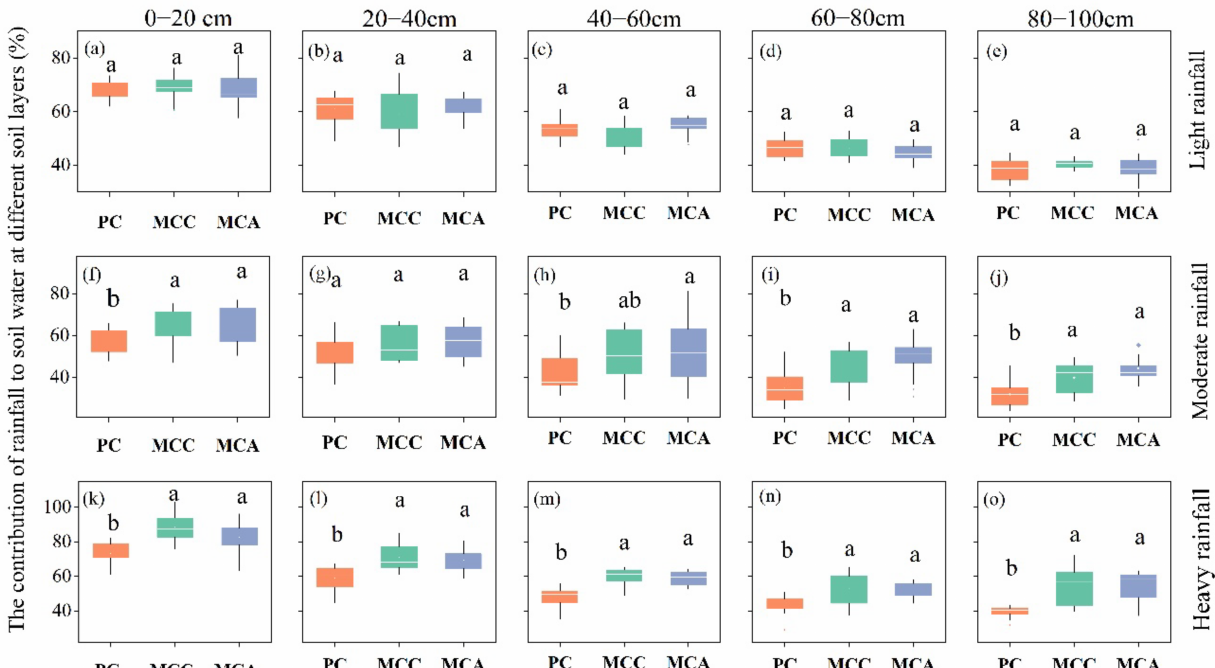
Figure 4. Comparison of the contribution of light ( a – e ), moderate ( f – j ) and heavy ( k – o ) rainfall to soil water among the three plantations. PC: pure C. lanceolata plantation; MCC: mixed plantation with C. lanceolata and C. camphora and MCA: mixed plantation with C. lanceolata and A. cremastogyne . The different lowercase letters indicate significant differences among the three plantations ( p <